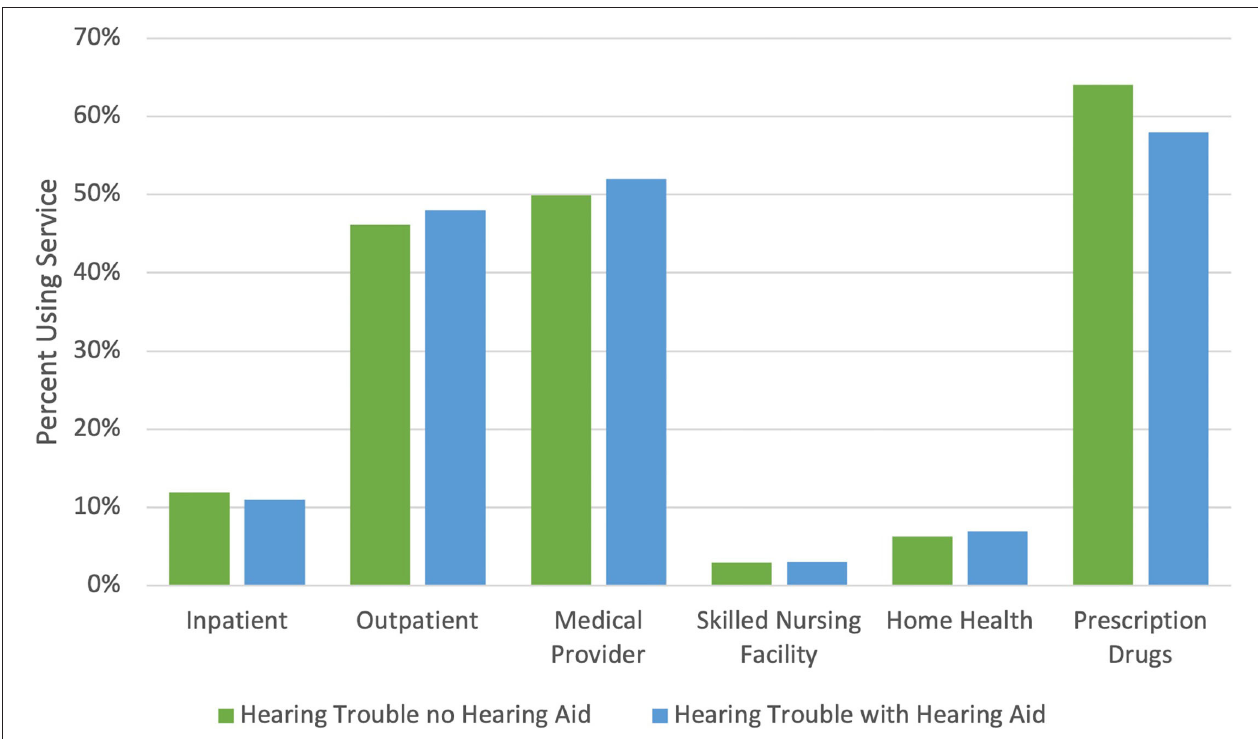
FIGURE 1 | Percent of Medicare beneficiaries with functional hearing trouble who report any utilization in 2017 by service type and hearing aid use. Source: Authors’ analysis of the Medicare Current Beneficiary Survey 2017. Medical provider includes medical doctor, nurse practitioner, physician assistant, and nurses. Prescription drugs do not include beneficiaries who report often receiving their prescription drugs in the mail or through the